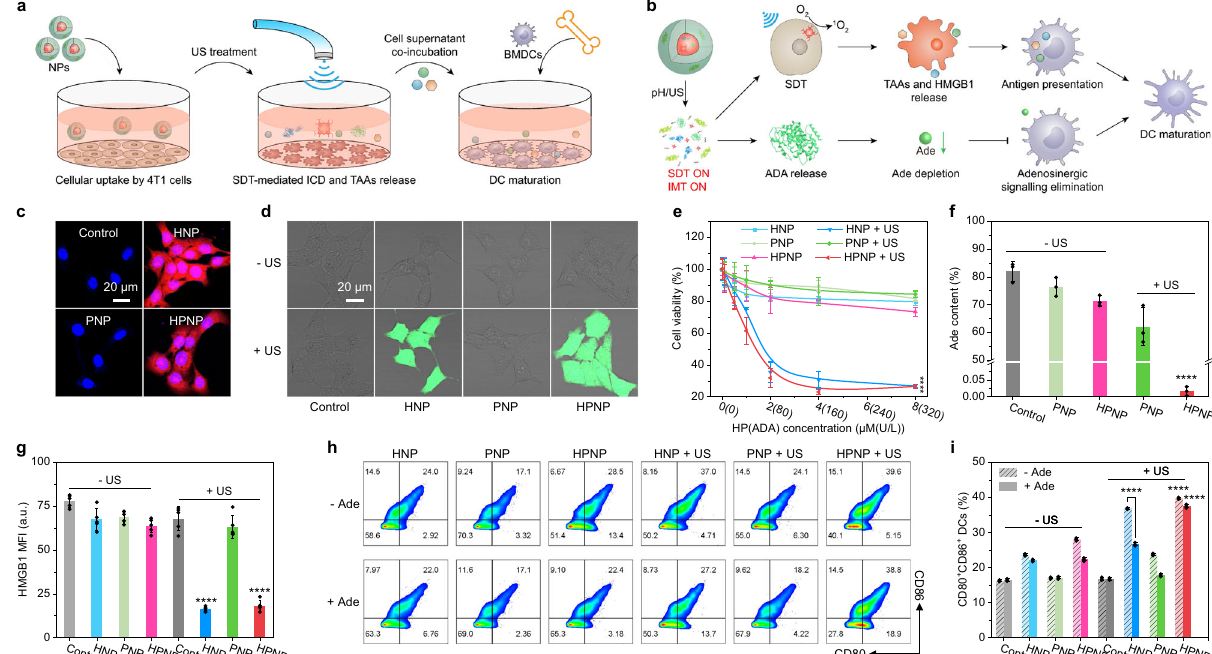
Fig. 3 In vitro nano-immunocomplex-mediated activatable sono-metabolic checkpoint trimodal cancer therapy. a Schematic illustration of experiment implementation for cellular uptake, SDT, ICD induction, and BMDC maturation. b Proposed mechanism of acidic TME/sono-activation of SDT and IMT for antigen presentation and DC maturation. c Confocal fl uorescence images of 4T1 cancer cells after 12 h incubation with HNP, PNP, or HPNP ([HP] = 20 μ mol/L or [ADA] = 800 U/L). d Confocal fl uorescence images of 4T1 cells after 12 h incubation with HNP, PNP, or HPNP ([HP] = 20 μ